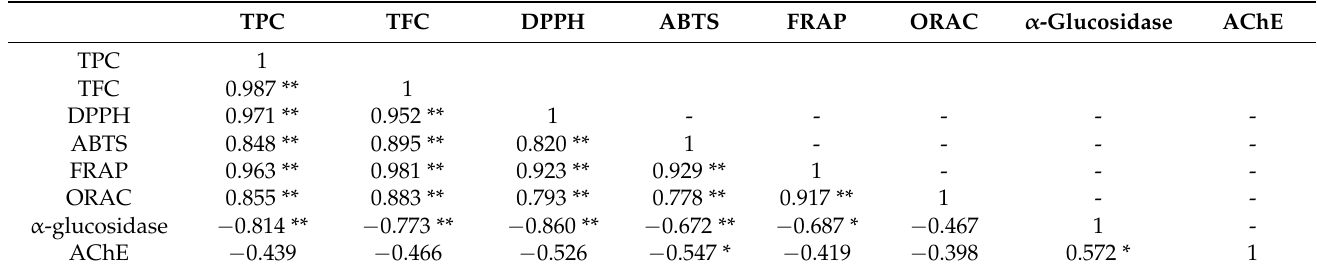
Figure 1. The DPPH radical scavenging ability of samples. The different letters in the column represented significantly difference ( p < 0.05). Table 2. The correlational analysis of each index of